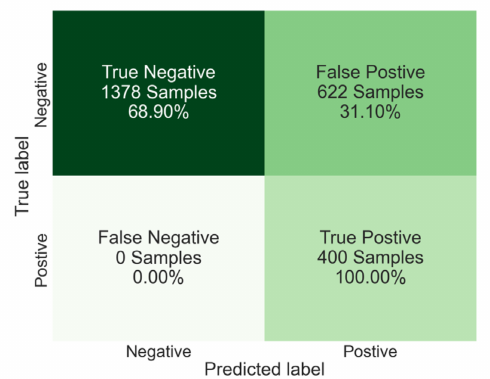
Figure 6. Confusion matrix of manual data analysis results with 2% difference threshold rule. The true-positive rate is 100% since the threshold is set for a 100% sensitivity rate. However, due to the high false-positive rate, the overall accuracy is 74.1%, precision is 39.1% and F1 score is